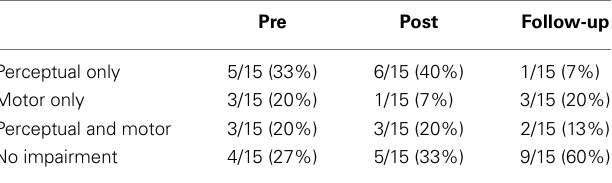
Table 3 | Percentage of IPD patients who exhibited impaired perceptual and/or motor timing relative to healthy controls pre-, post-training, and at the follow-up